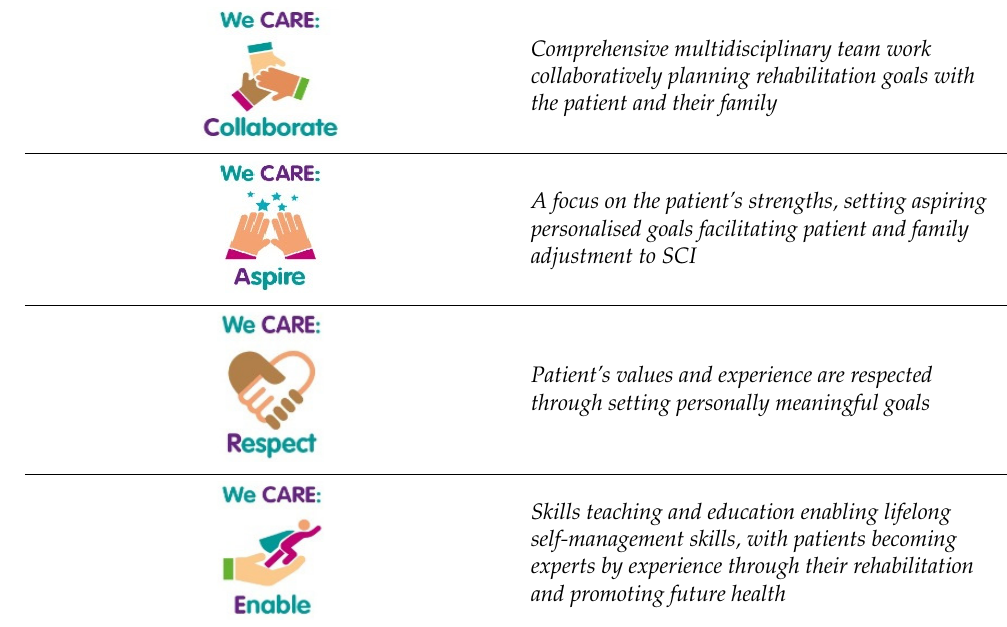
Table 11. BHT’s organisational values.